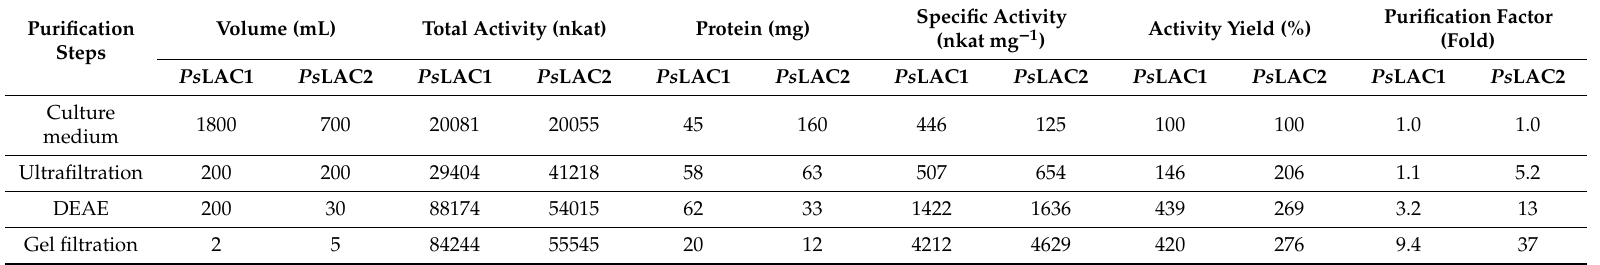
Table 1. Purification steps for each recombinant laccase produced in Aspergillus niger D15. DEAE: